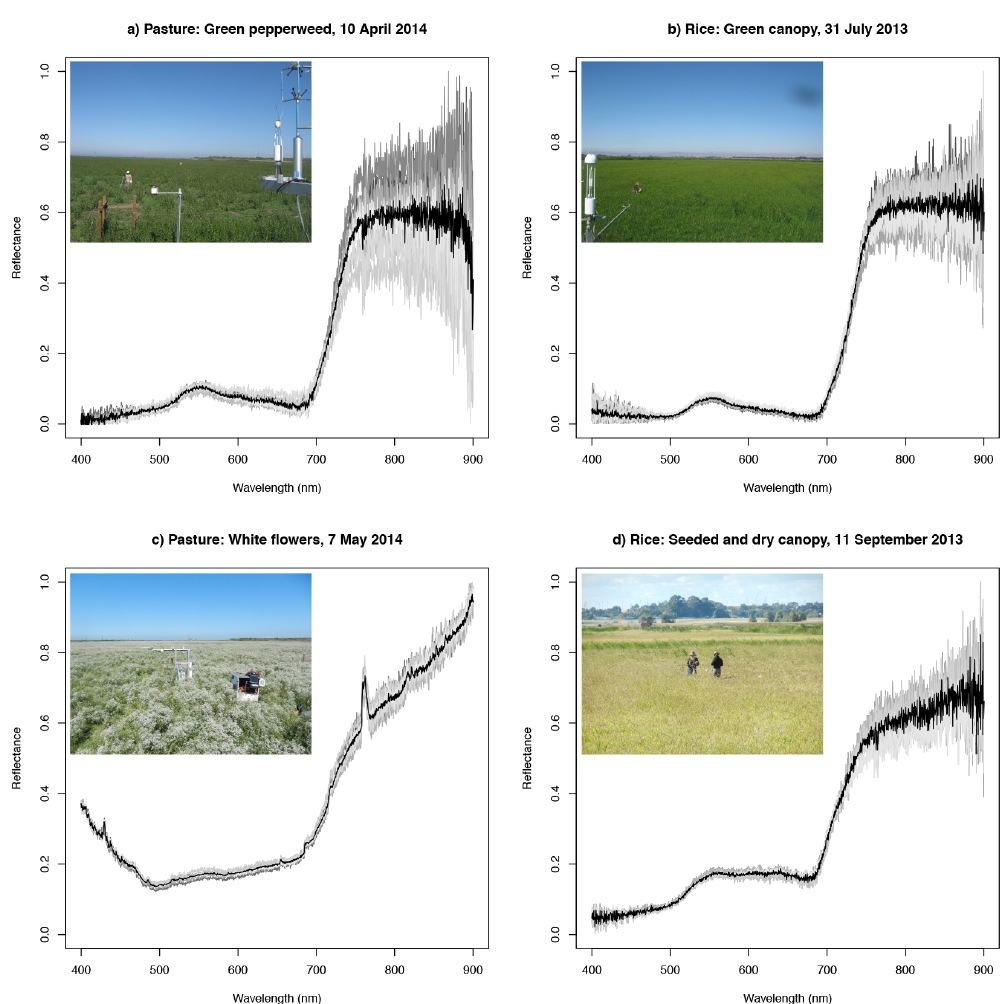
Figure 3. Daily variability in measured canopy hyperspectral reflectance during phenological events. (a–b) Daily measured hyperspectral canopy reflectance for the Pasture and Rice sites when the canopy was closed and green, at the Pasture on 10 April 2014 and the Rice on 31 July 2013. Reflectance was very low in the visible wavelengths due to canopy absorption, but quite large in the near-infrared re- flectance with a high amount of variability. Both sites had spectral peaks that corresponded to green reflectance ( ∼ 550nm) and troughs that corresponded to spectral absorption in red reflectance ( ∼ 675nm). (c) During the white flowering of the pepperweed plants, the measured reflectance changed significantly, due to the higher albedo of the bright white flowers. There was much higher reflectance across the spectrum during this time, and the white flowers obfuscated reflectance in the wavelengths that corresponded to plant productivity. (d) There was a similar but not as dramatic shift in increased albedo, particularly across the visible wavelengths from green to red reflectance during the rice seeding and senescence as the canopy dried before harvest. However, an important distinction between this phenological event and the white flowering at the Pasture is that the productivity of the rice plants was quite low at this time, in contrast with the higher productivity of the pepperweed during